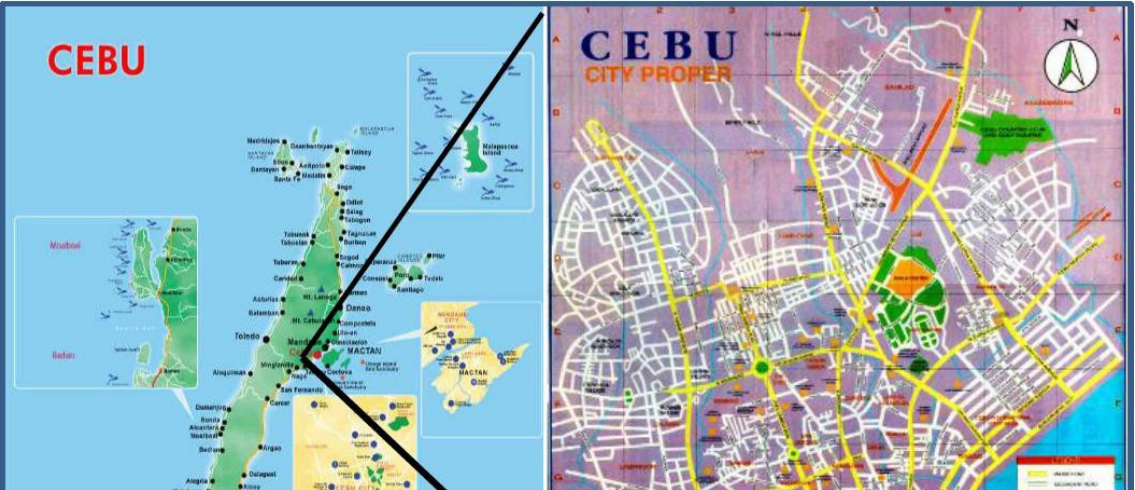
Figure 1. Map of Cebu City Proper where sampling stations were